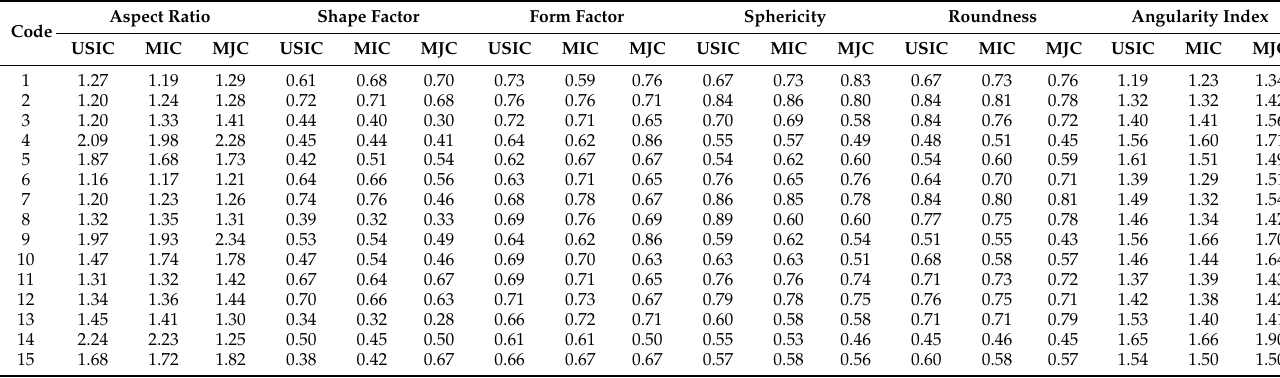
Table 5. The average values of aggregate shape properties for USIC, MIC &